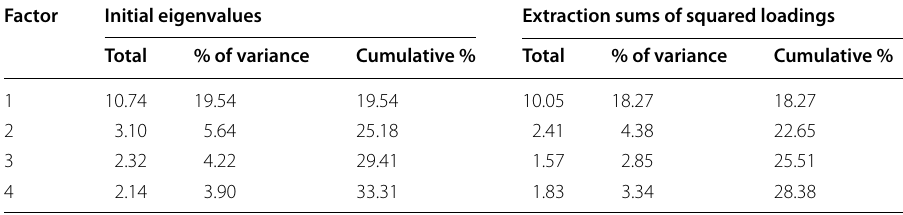
Extraction method: principal axis factoring